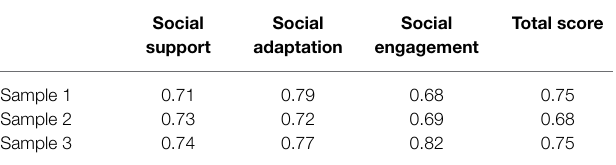
TABLE 6 | Cronbach’s α coefficients of three